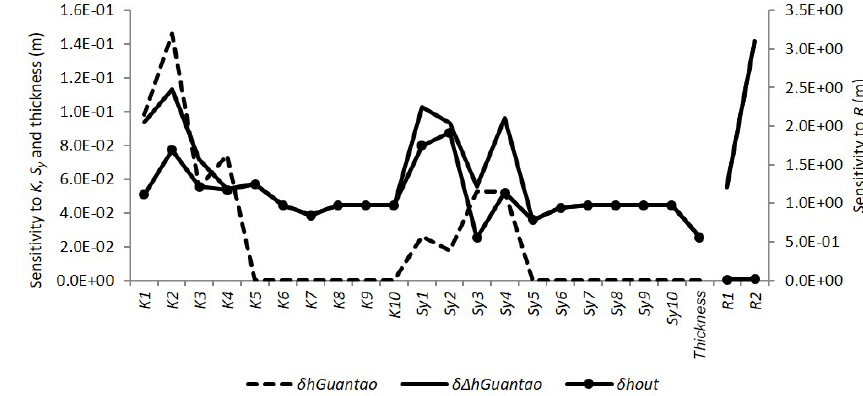
Figure 13. The normalized sensitivity of head change and contributions to parameters and recharge